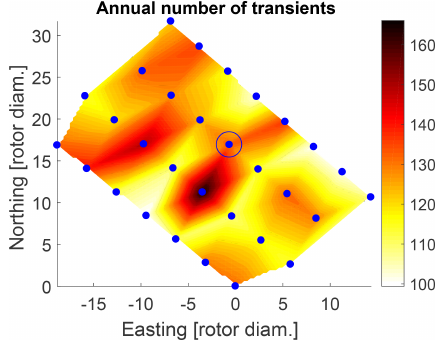
Figure 14. Number of start-up and shutdown events within wind farm from SCADA data.